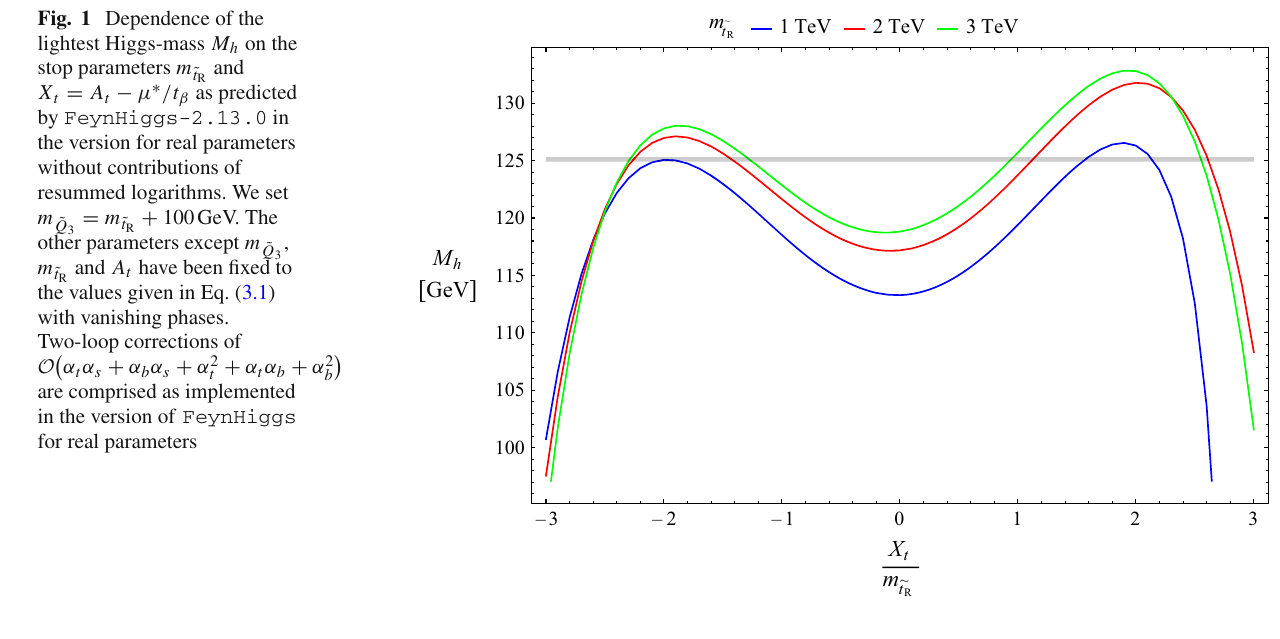
Fig. 1 Dependence of the lightest Higgs-mass M h on the stop parameters m ˜ t and R X t = A t − μ ∗ / t β as predicted by FeynHiggs-2.13.0 in the version for real parameters without contributions of resummed logarithms. We set = m ˜ + 100GeV. The m ˜ t R Q 3 other parameters except m ˜ , Q 3 m ˜ t and A t have been fixed to R the values given in Eq. (3.1)